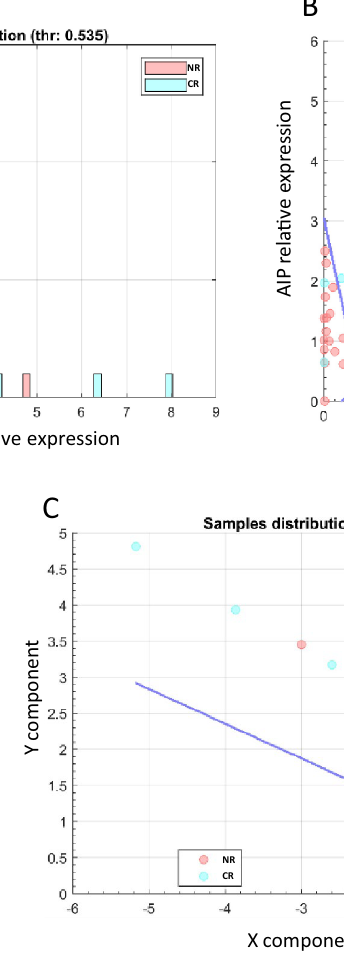
Figure 2. Representation of different possible models resulting from the data mining analysis in the whole cohort. ( A ) Sampling distribution graph representing the distribution of CR and NR patients for E-cadherin expression. When the classifier contains only one variable we used a variable brute force technique. The discriminant function is a constant that is determined as the threshold value that separates samples from the two groups with the best accuracy (marked by dotted red line). ( B ) Sampling distribution graph in 2D representing the distribution of CR and NR patients for the expression of AIP and E-cadherin. The blue line is the mathematical function defined by the values of the classifier, a mathematical function that separates NR from CR patients. As this classifier is composed of two variables, each dimension of the graph stands for one variable. The variables were selected by the Lasso method and the model performed according to Multilayer perceptron (MLP) methodology. ( C ) Sampling distribution graph in 2D representing the distribution of CR and NR patients for the expression of SSTR2 , E-cadherin and AIP . As this classifier is composed of more than two variables, each dimension of the grafh stands for the the two main components after performing a principal component analysis (PCA). The blue line is the mathematical funtion that separates CR from NR patients. The variables were selected by the Wilcoxon method and the model performed according to Multilayer perceptron (MLP)